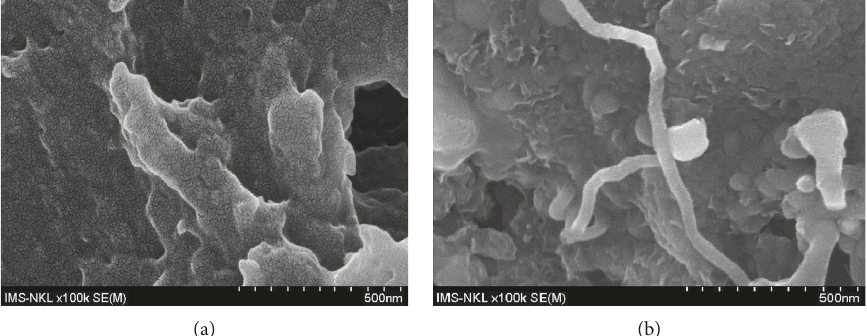
Figure 3: SEM images at high magnifications ( × 100,000) of CNT/P nanocomposites: before (a) and after (b)